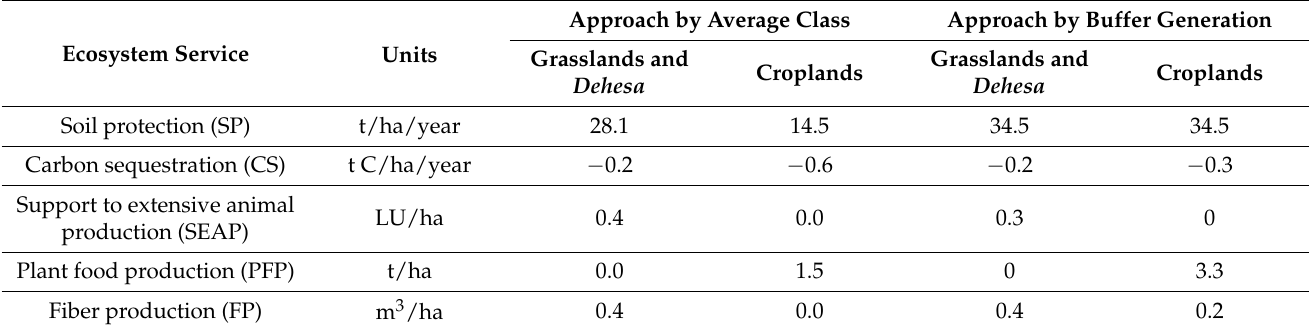
Table 2. Average ecosystem service level per unit of area for the two modelling